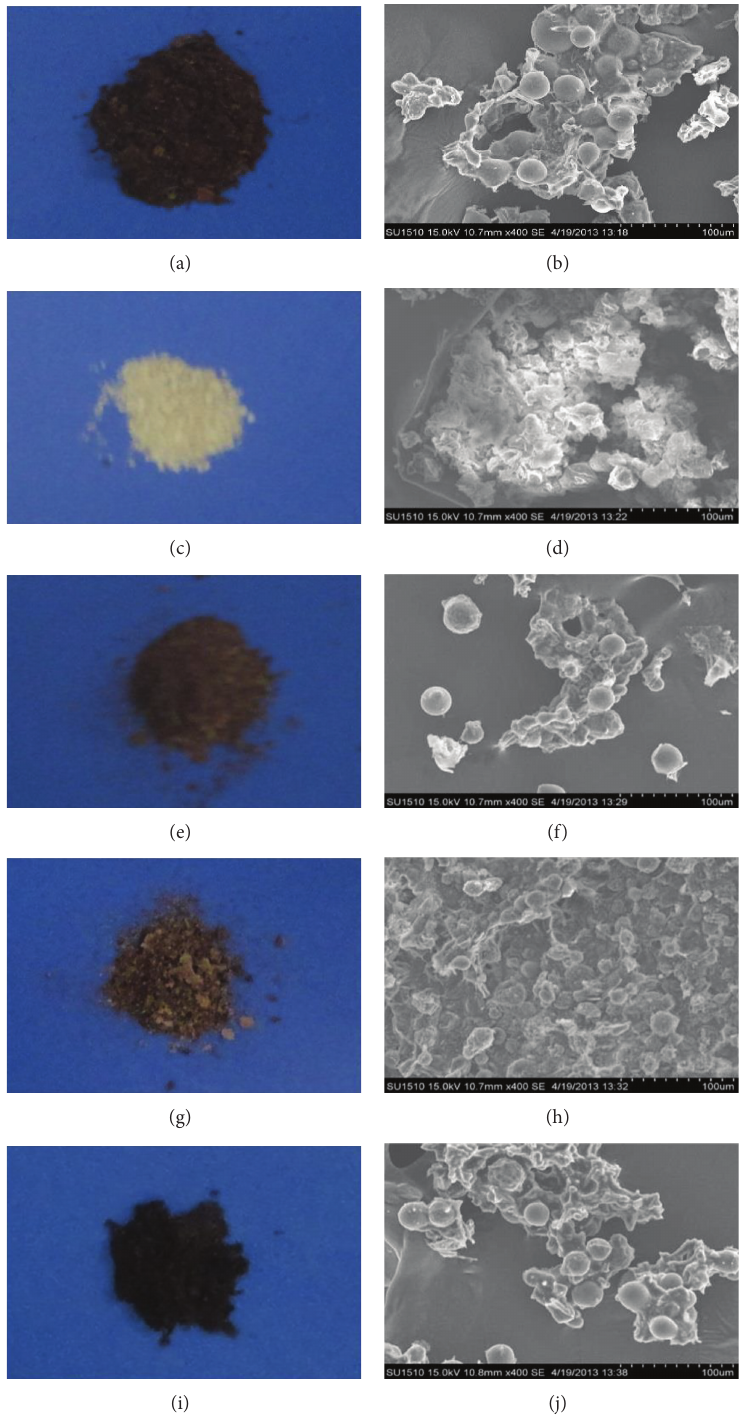
Figure 1: Photoes and SEM analysis of H. pluvialis cell after different extraction methods. (a) H. pluvialis cell material photo before extraction, (b) cell SEM before extraction; (c) H. pluvialis cell material photo after HCI-ACE extraction, (d) cell SEM after HCI-ACE extraction; (e) cell material photo after HEX-IPA extraction, (f) cell SEM after NEX-IPA extraction; (g) cell material photo after MET-ACE extraction, (h) cell SEM after MET-ACE extraction; (i) cell material photo after oil-soy extraction, (j) cell SEM after oil-soy